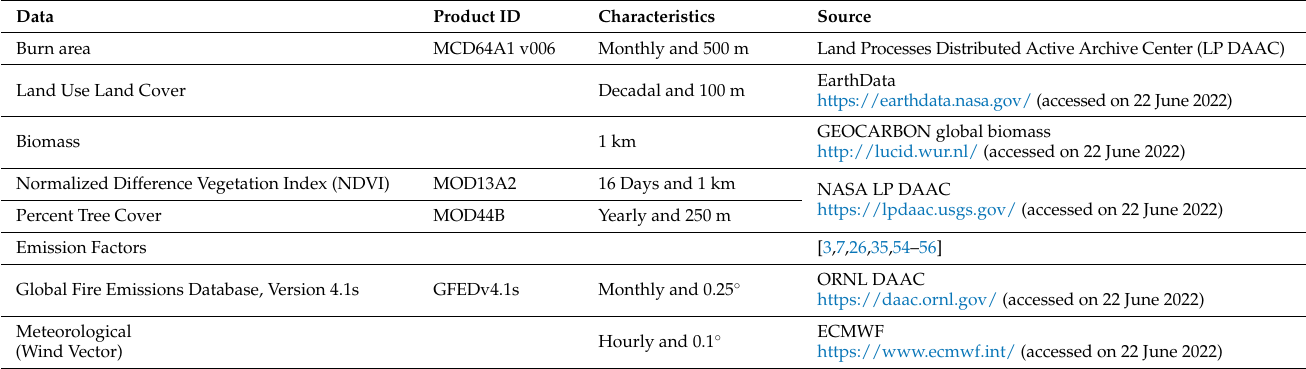
Table 1. List of the datasets used to accomplish the pixel-based estimation of forest fire